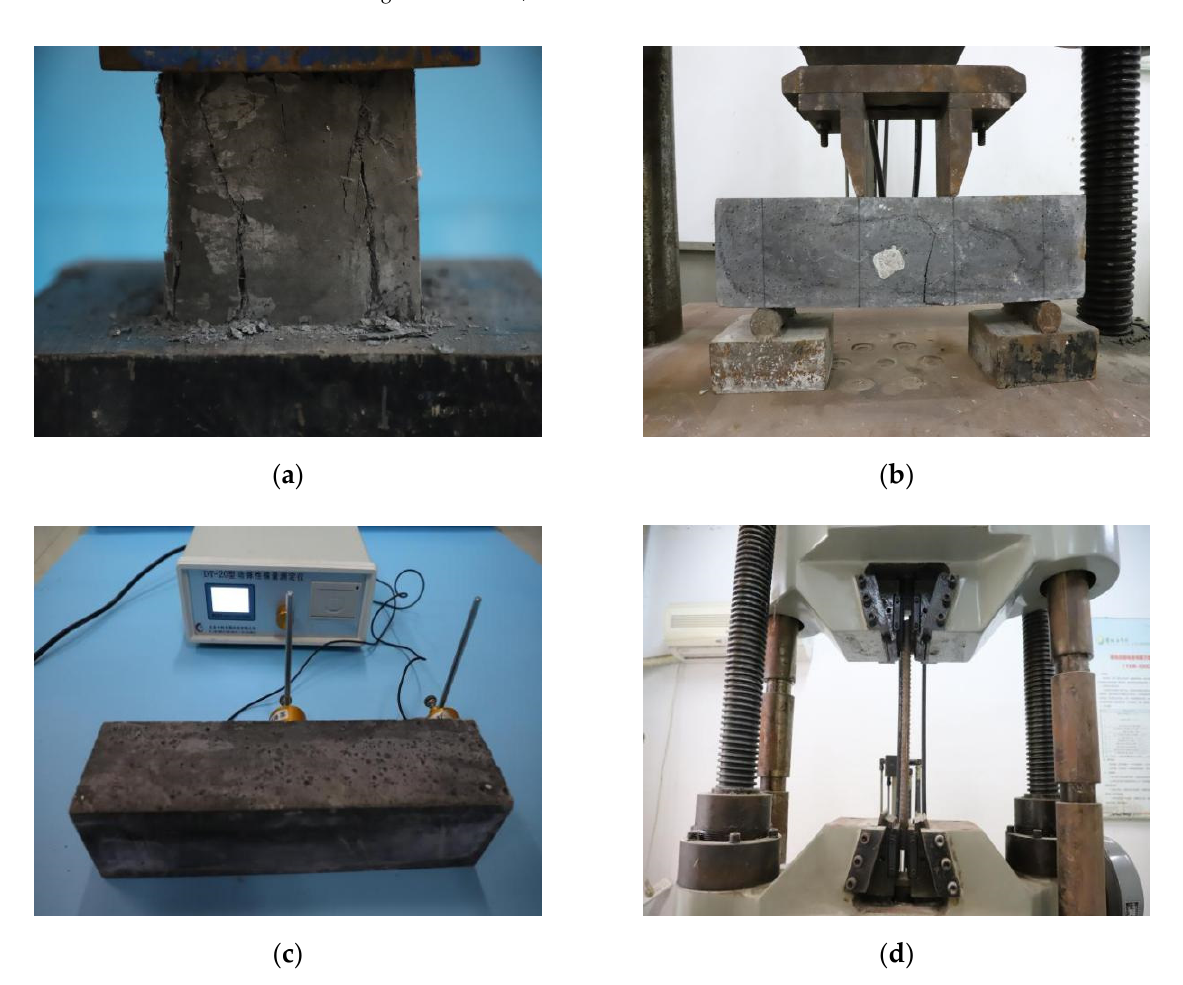
Figure 3. Measurement of mechanical properties: ( a ) concrete compression test; ( b ) concrete bending test; ( c ) concrete elastic modulus test; ( d ) rebar tensile test.